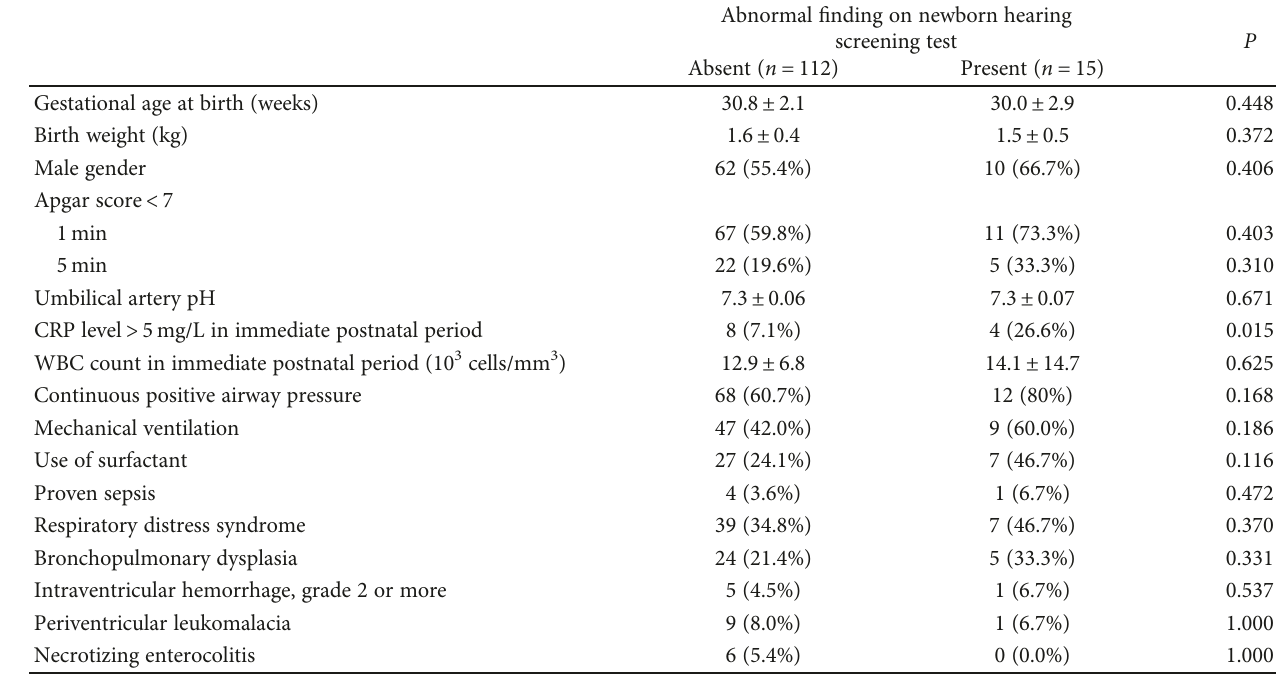
Table 3: Neonatal characteristics and morbidities according to newborn hearing screening test results.